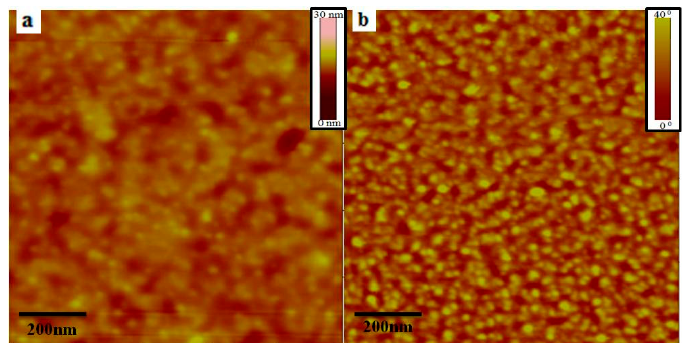
(10% wt.) corresponding to the 192 h SVA treated composite